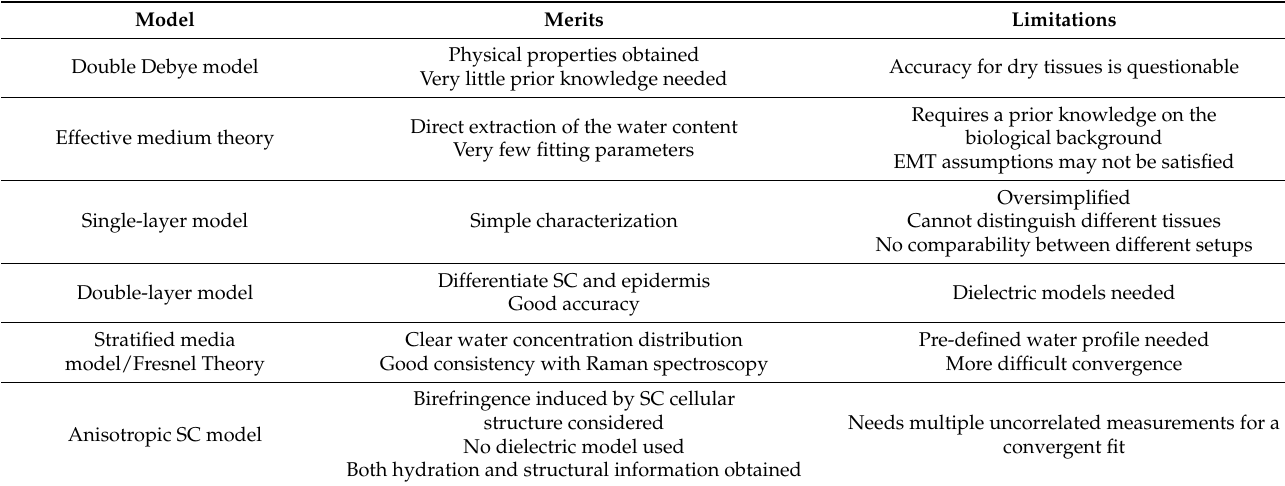
Table 1. Comparison of different